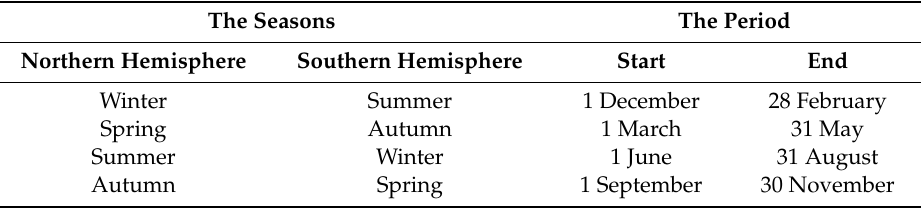
Table 2. The seasons according to meteorological temperate seasons.